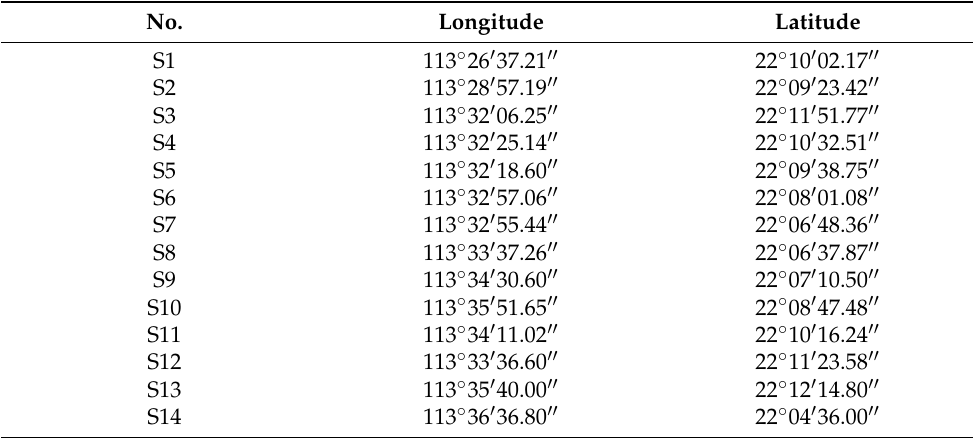
Table A1. The GPS message of sampling